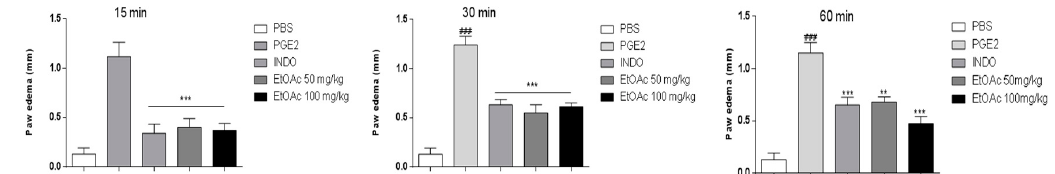
Figure 4. Reduction of paw edema (induced by the PGE challenge) in the presence of EtOAc of A. occidentale at 15, 30 and 60 min. Results were expressed as mean SEM and analysed by graphpad Prism using ANOVA followed by the test Dunnett or Mann–Whitney, where all groups were compared.